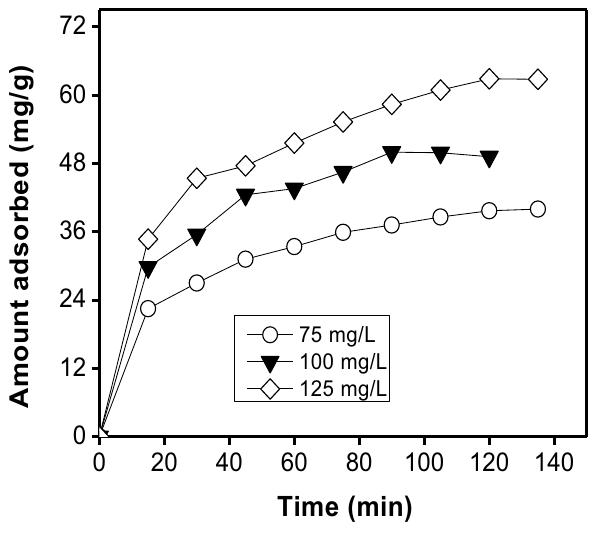
Fig. 6 Adsorption of Pb(II) on DES/H initial concentration (dosage = 0.2